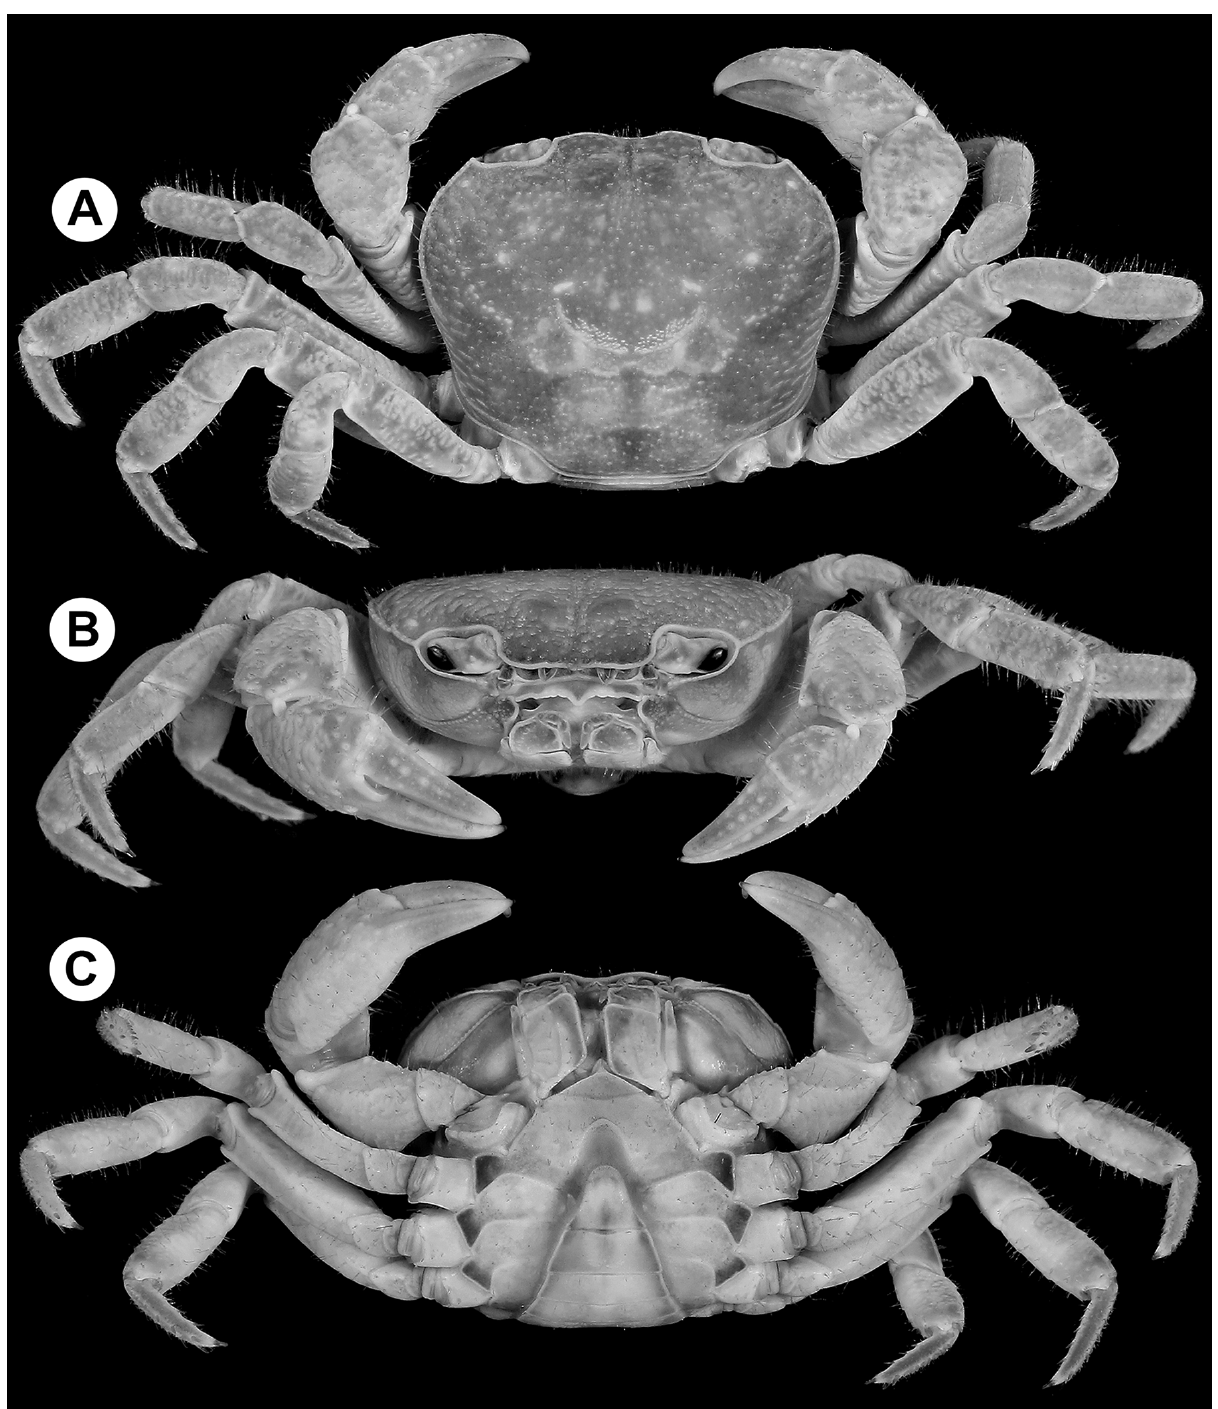
Figure 1. Abormon praecalvum sp. nov., holotype male (12.9 × 10.5 mm) (ZSI-WRC C.1941). A , overall dorsal view; B , overall frontal view; C , overall ventral